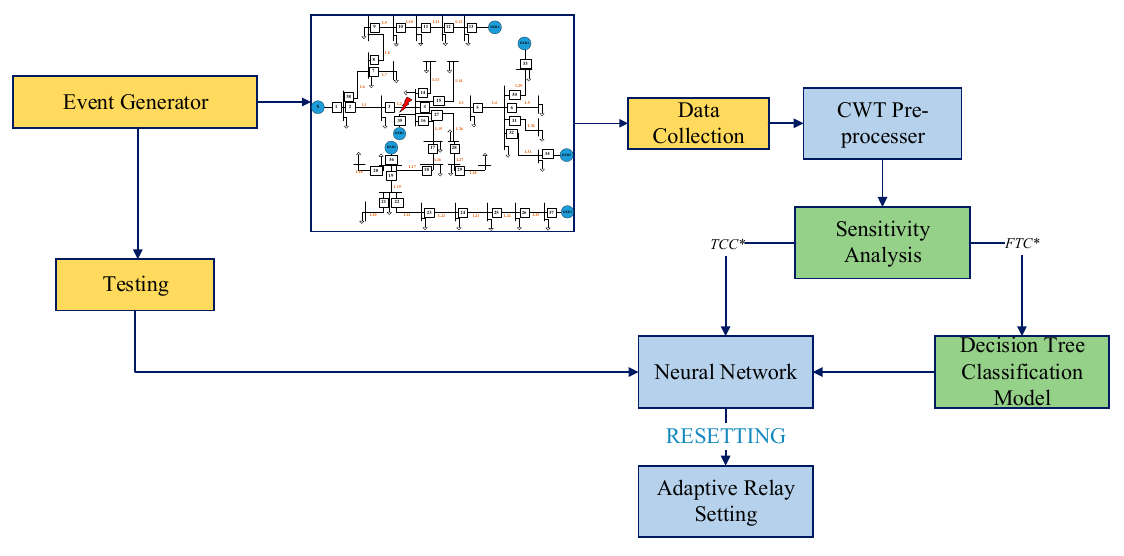
Figure 2. General overview of the proposed method.